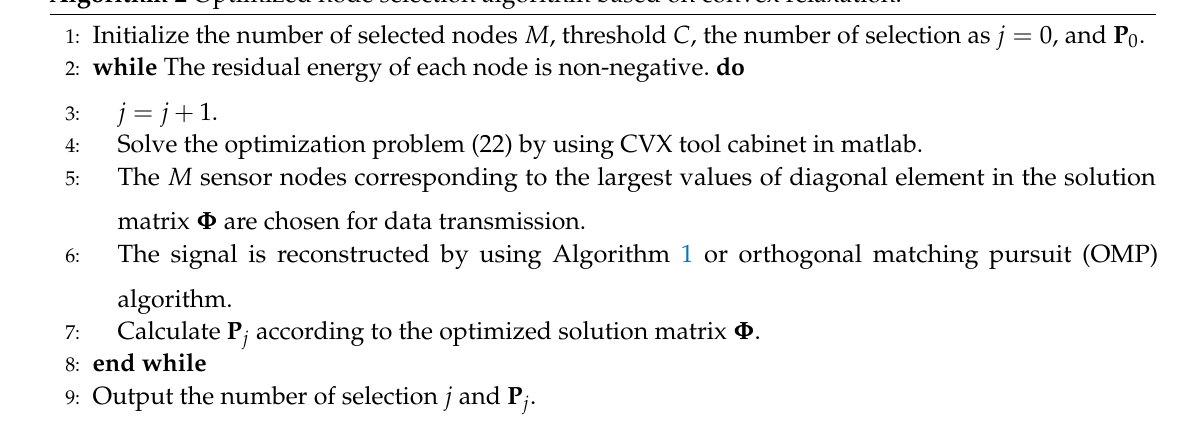
Algorithm 2 Optimized node selection algorithm based on convex